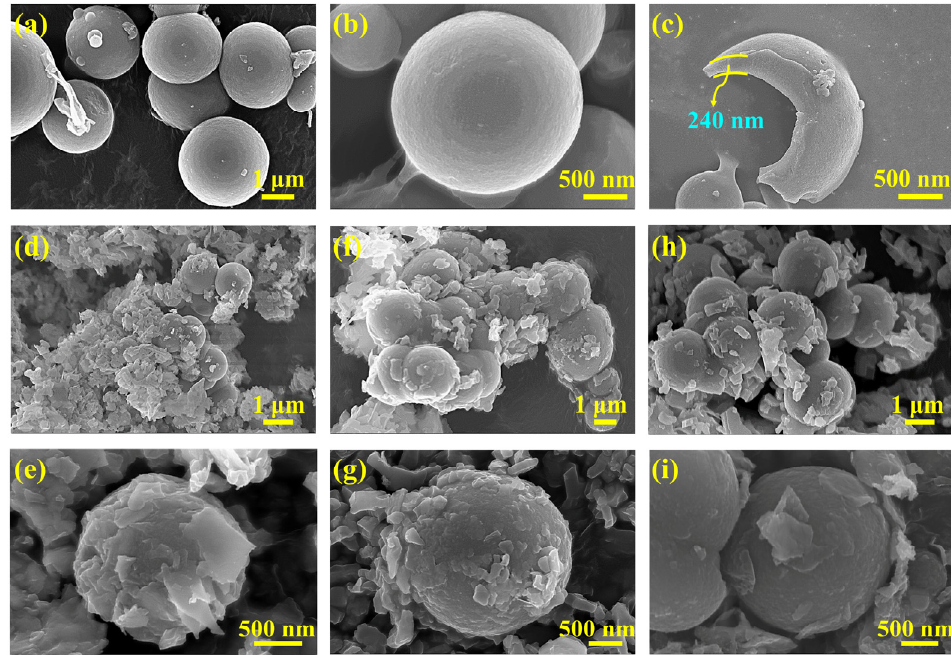
Figure 2. SEM micrographs of ( a – c ) SiO 2 /Fe 3 O 4 -MEPCM, ( d , e ) BiOI-MEPCM (1.5:1), ( f , g ) BiOI- MEPCM (1:1), and ( h , i ) BiOI-MEPCM (0.5:1).